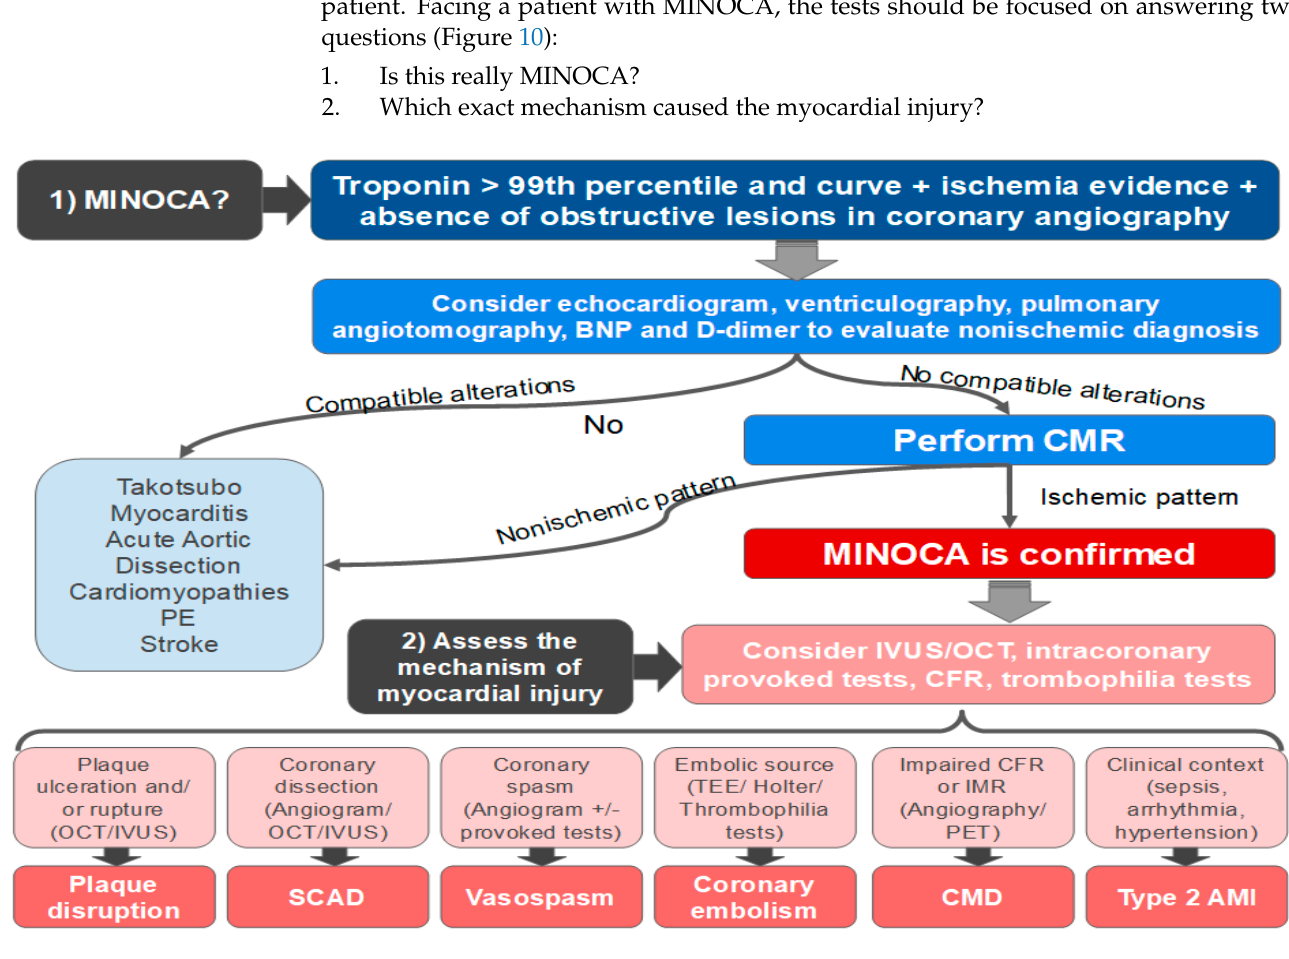
Figure 10. Flowchart for the diagnosis of MINOCA. BNP = brain natriuretic peptide; CMD = coronary microvascular dysfunction; CFR = coronary flow reserve; IMR = microvascular resistance indices; IVUS = intravascular ultrasound; MINOCA = myocardial infarction with non-obstructive coronary arteries; AMI = acute myocardial infarction; CMR = cardiac magnetic resonance; OCT = optical coherence tomography; PE = pulmonary embolism; PET = positron emission tomography; SCAD = spontaneous coronary artery dissection.